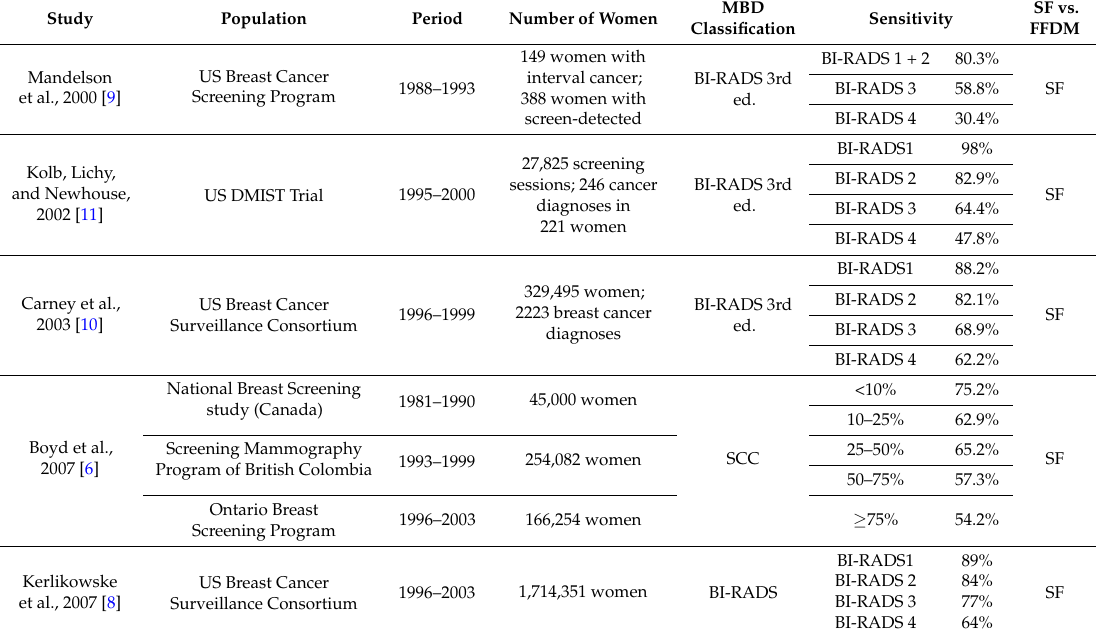
Table 2. Sensitivity of mammography by density category in US population-based